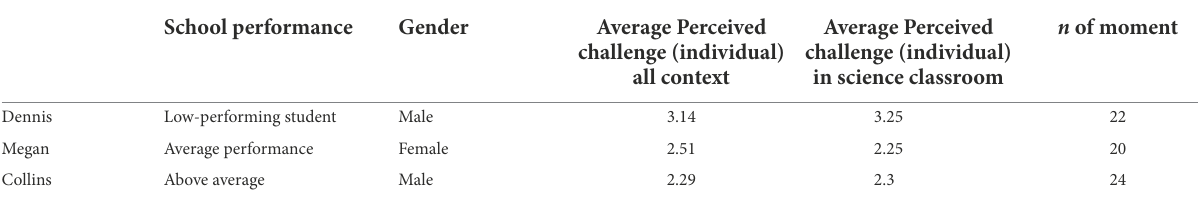
TABLE 5 Three student case